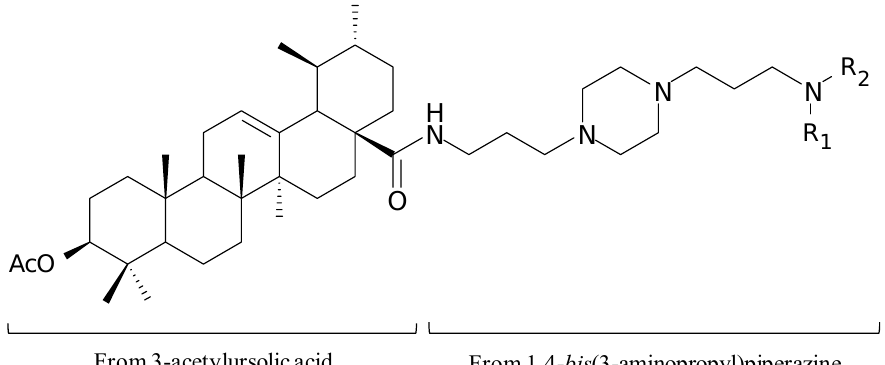
From 3-acetylursolic acid From 1,4- bis